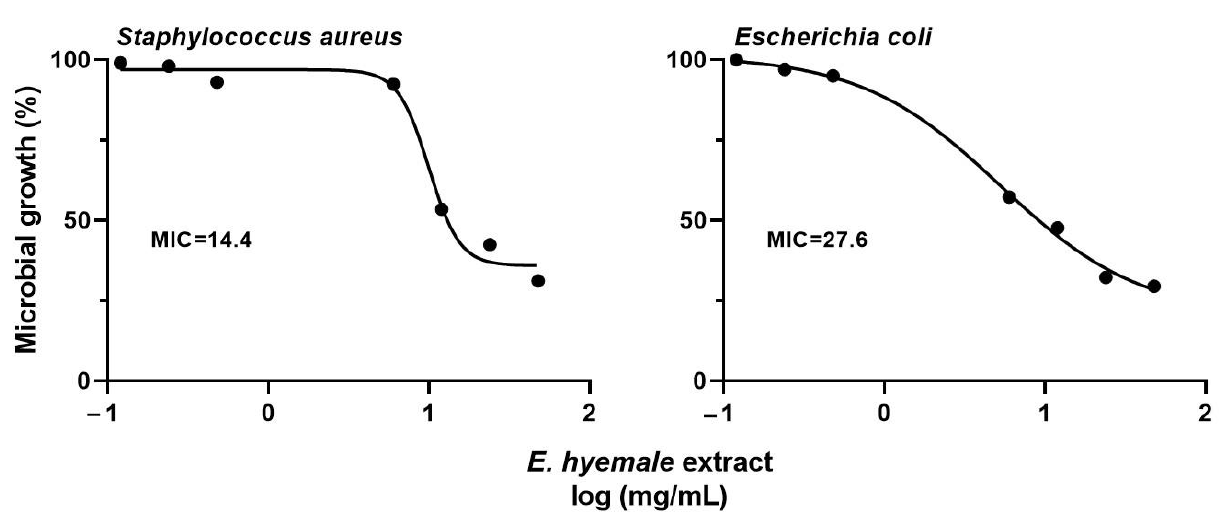
Figure 6. Effect of E. hyemale extract on the microbial growth of Staphylococcus aureus and Escherichia coli after 48 h of treatment. Minimum inhibitory concentration (MIC: mg/mL).